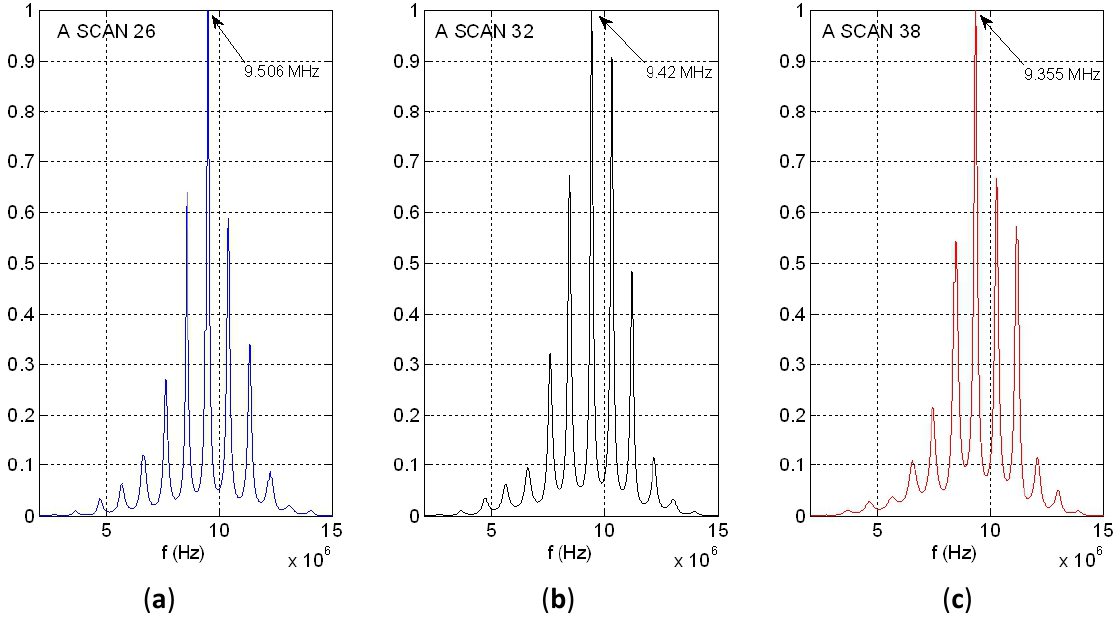
Figure 14. PSD of the tube wall echo related to the A-Scans number 26, 32 and 38 using our